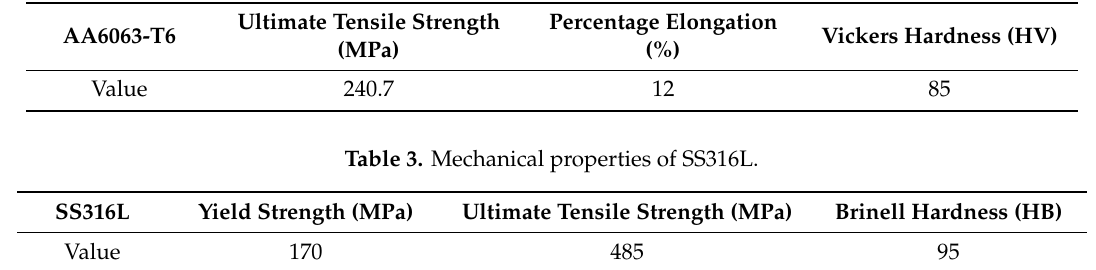
Table 2. Mechanical properties of AA6063-T6.